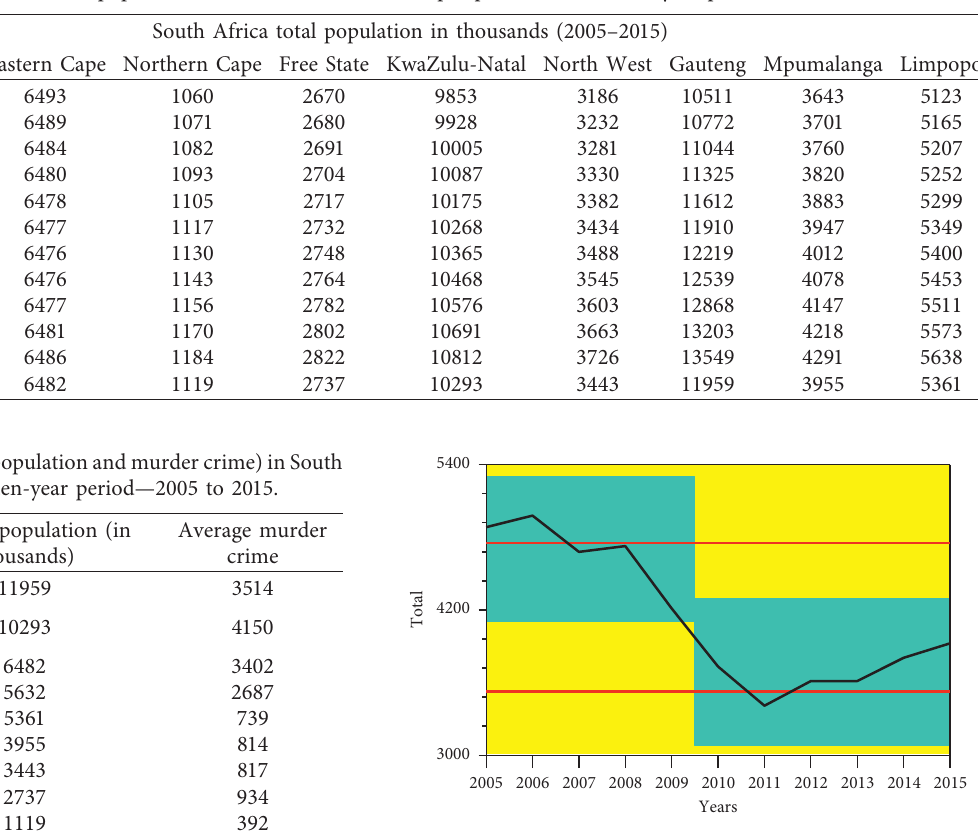
Figure 2: KwaZulu-Natal: background